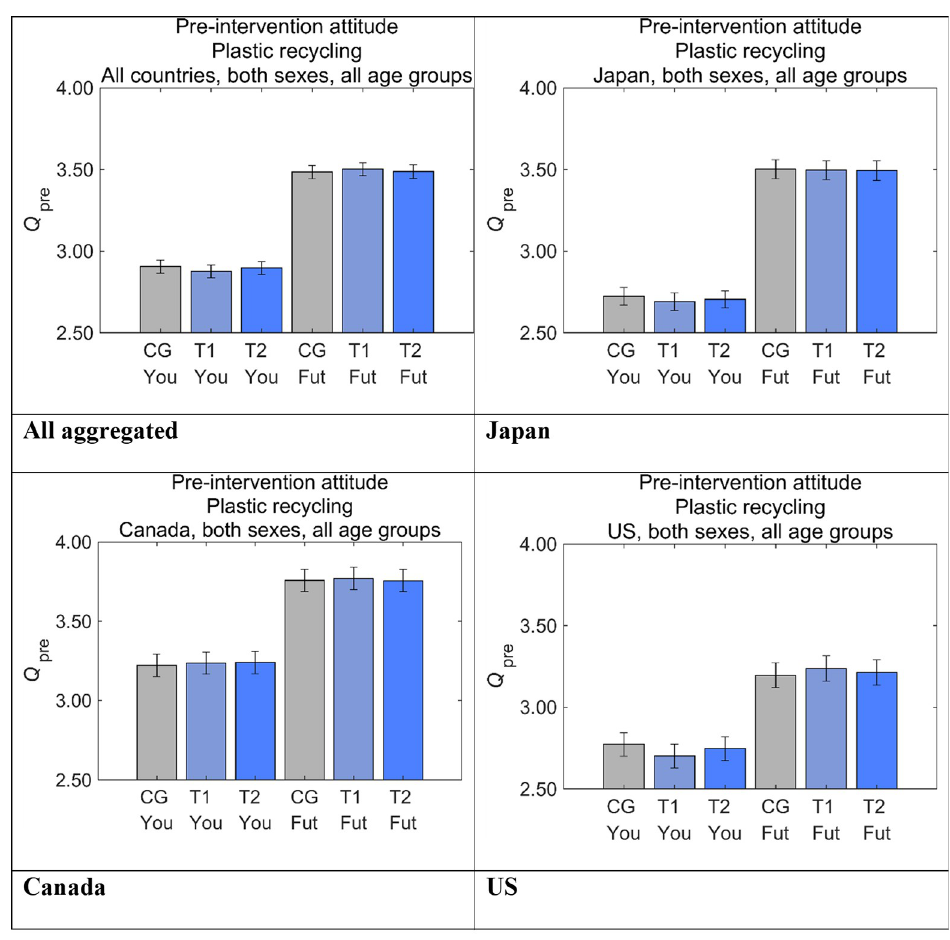
Fig 7. Risk perception on disposable plastics by group before receiving the designed messages. Higher values on the vertical axis indicate higher perceived risks. Error bars show 95% confidence intervals. CG, control group; T1, treatment group 1; T2, treatment group 2; Fut, Future Generations; You,